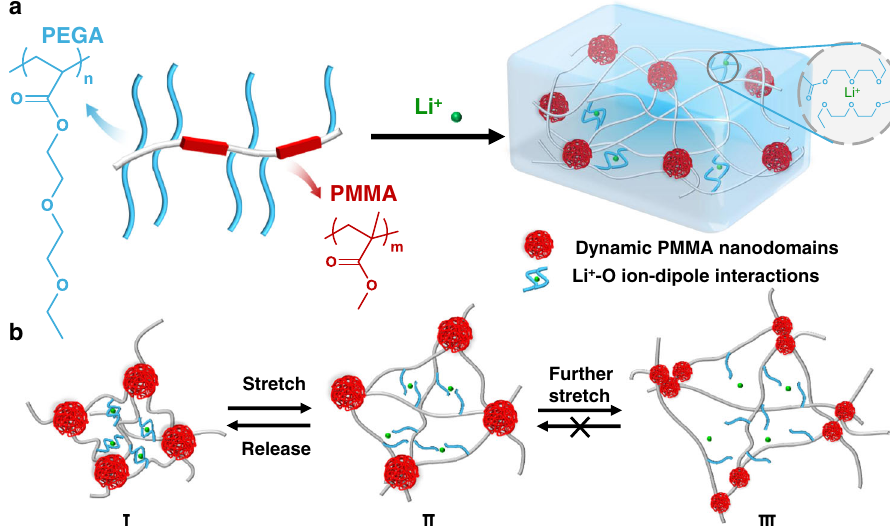
Fig. 2 Structure design. a Chemical structure design and scheme of the double-crosslinking structure. b Proposed mechanism for bond breakage and reformation during tensile stretching: I. Initial II. At small strain, Li + -O weak bonds can easily break, but it can reform once the stress is removed. III. At large strain, PMMA nanodomains break into smaller parts to further dissipate energy.